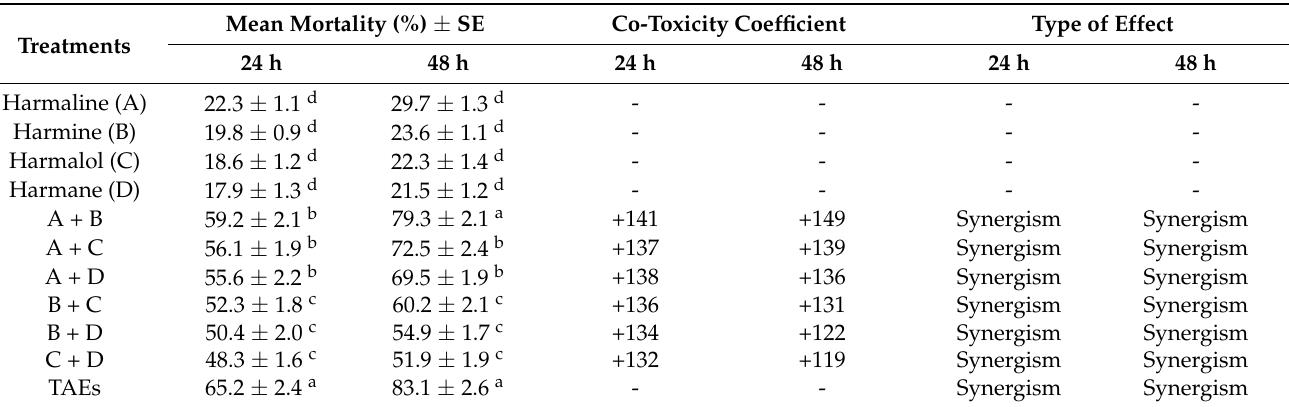
Table 1. Toxicity of total alkaloid extracts (TAEs) and isolated alkaloids from Peganum harmala seeds and their binary mixtures prepared as LC 25 combinations against second-instar larvae of Aedes albopictus .